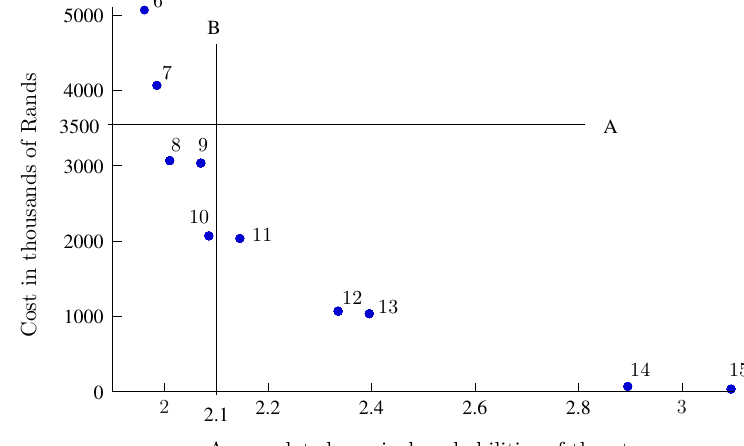
Figure 6: Graphical illustration of the set of approximately Pareto optimal solutions obtained by means of the NSGA II for stage t